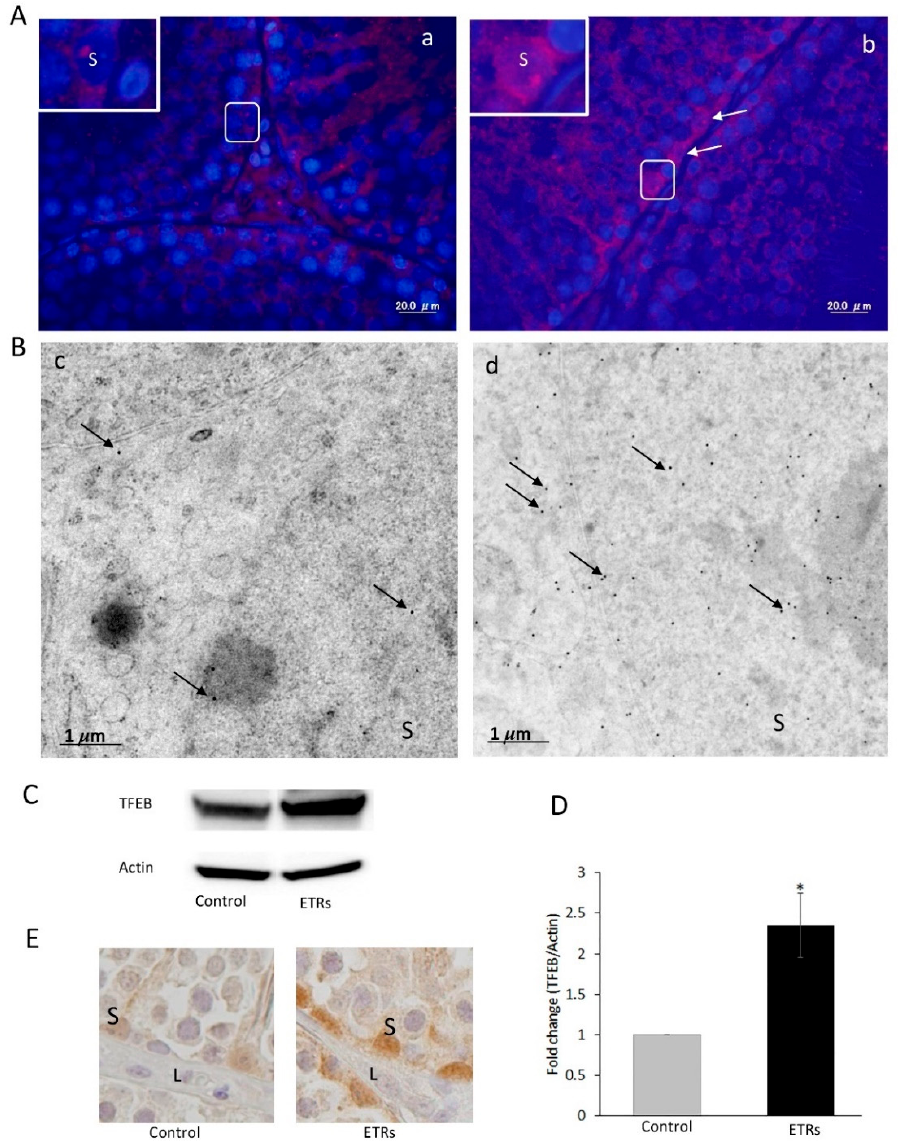
Figure 8. Elevated expression and nuclear translocation of TFEB in ETR SCs. ( A ) IF of TFEB expression in the control ( a ) and ETRs ( b ). The insets are higher magnifications of the framed areas. Note the overexpression of TFEB (white arrows) in SC nuclei of ETRs. ( B ) Immunogold labeling of TFEB (black arrows, 15 nm gold particles) in the control ( c ) and ETR SCs ( d ). ( C ) Western blot of TFEB in the control and ETR testes ( n = 3). ( D ) Histogram showing a significant increase of TFEB expression in ETR testes. * p < 0.05 ( t -test). ( E ) IHC showing TFEB nuclear translocation in ETR SCs (part of a seminiferous tubule), confirming the IF and IEM results ( A , B ). S: SC nucleus; L: Leydig cell.